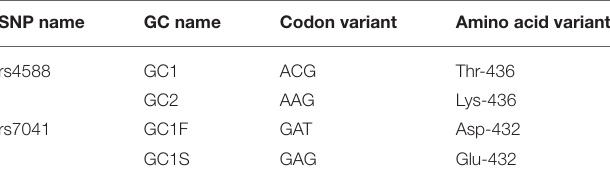
TABLE 4 | Molecular biology of most common DBP